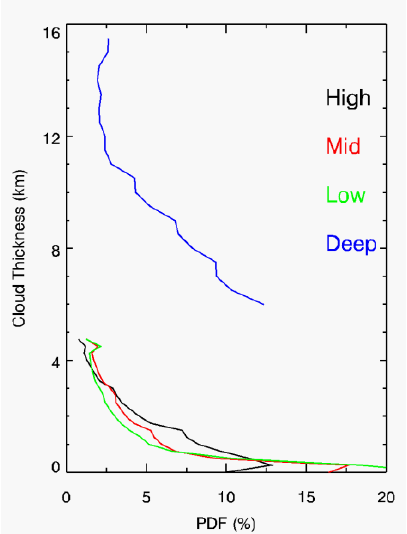
Figure 10. PDFs of cloud thickness for low-level, mid-level, high-level, and deep clouds.